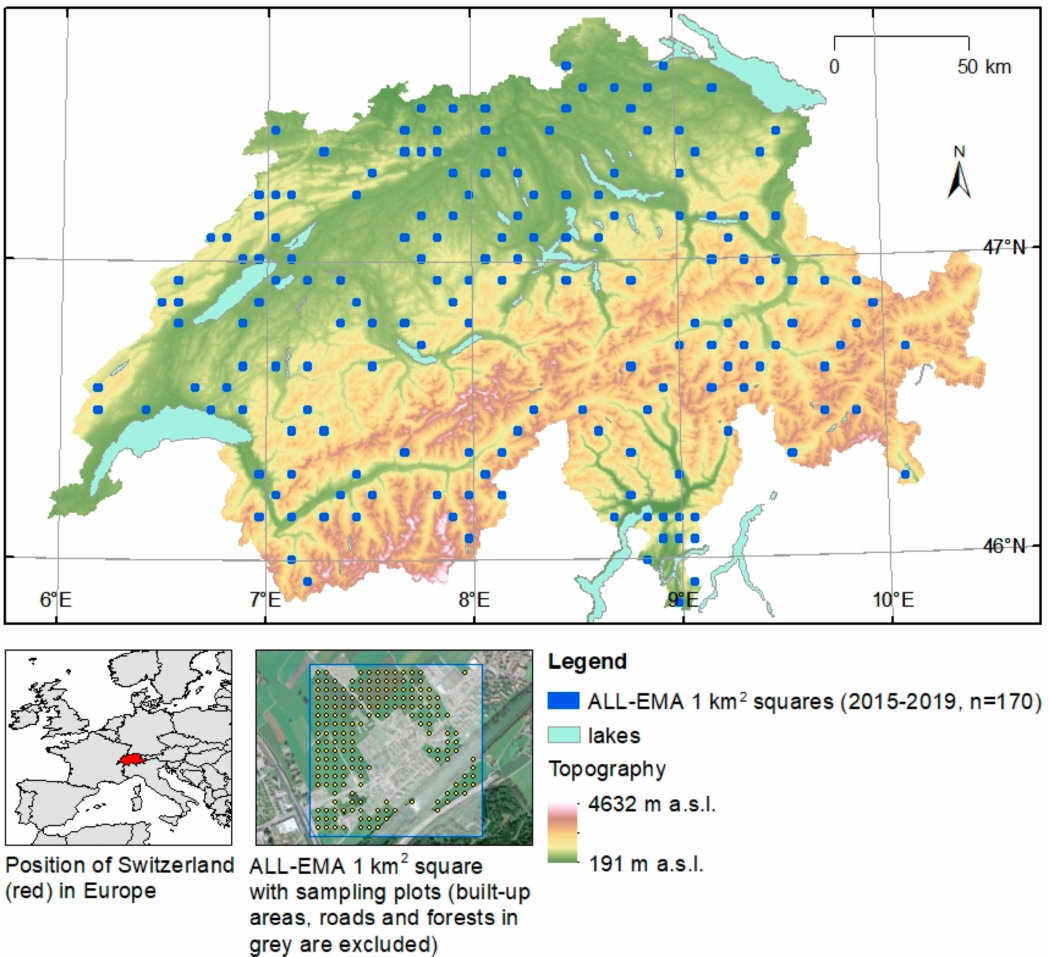
Figure 2. Location of study area showing the 170 landscape squares of Switzerland’s farmland species and habitat monitoring program ALL-EMA (blue squares) and the farmland species and habitat monitoring plots within the agricultural landscape on a 50 m mesh (yellow